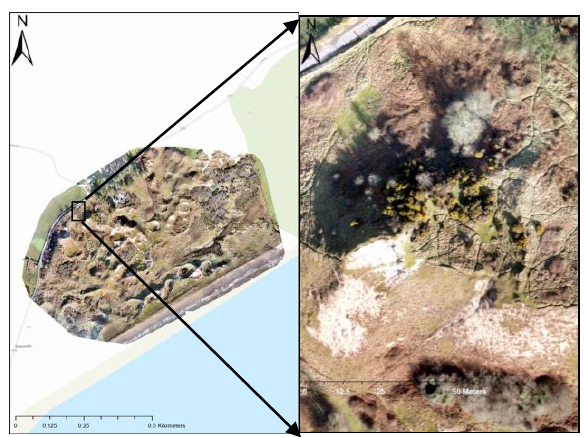
Figure 5. Orthomosaic model of study site and the detail of a selected area.